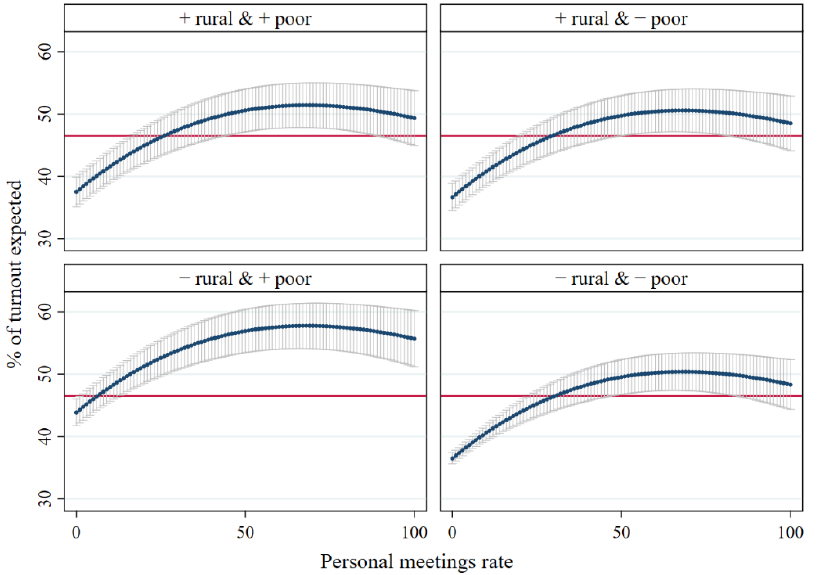
Figure 4. Predicted values of electoral turnout according to personal meetings rate (by group of municipalities). Source: prepared by the authors with data from www.servel.cl and www.infolobby.cl (accessed on 21 March 2021).